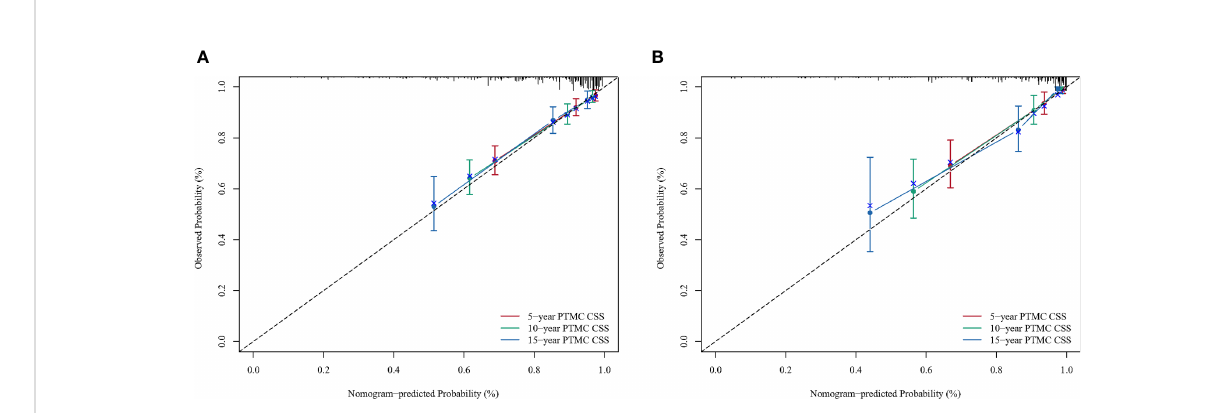
FIGURE 5 Calibration plots for predicting BC-PTML-speci fi c survival at 5-, 10-, and 15-years in the training (A) and validation (B) cohorts.